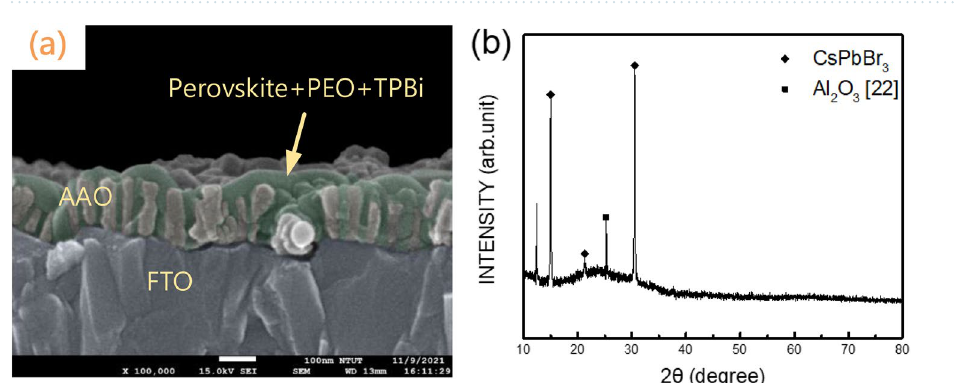
Figure 3. ( a ) Cross-sectional SEM image and ( b ) XRD pattern of the CsPbBr 3 perovskite film coated onto and into AAO